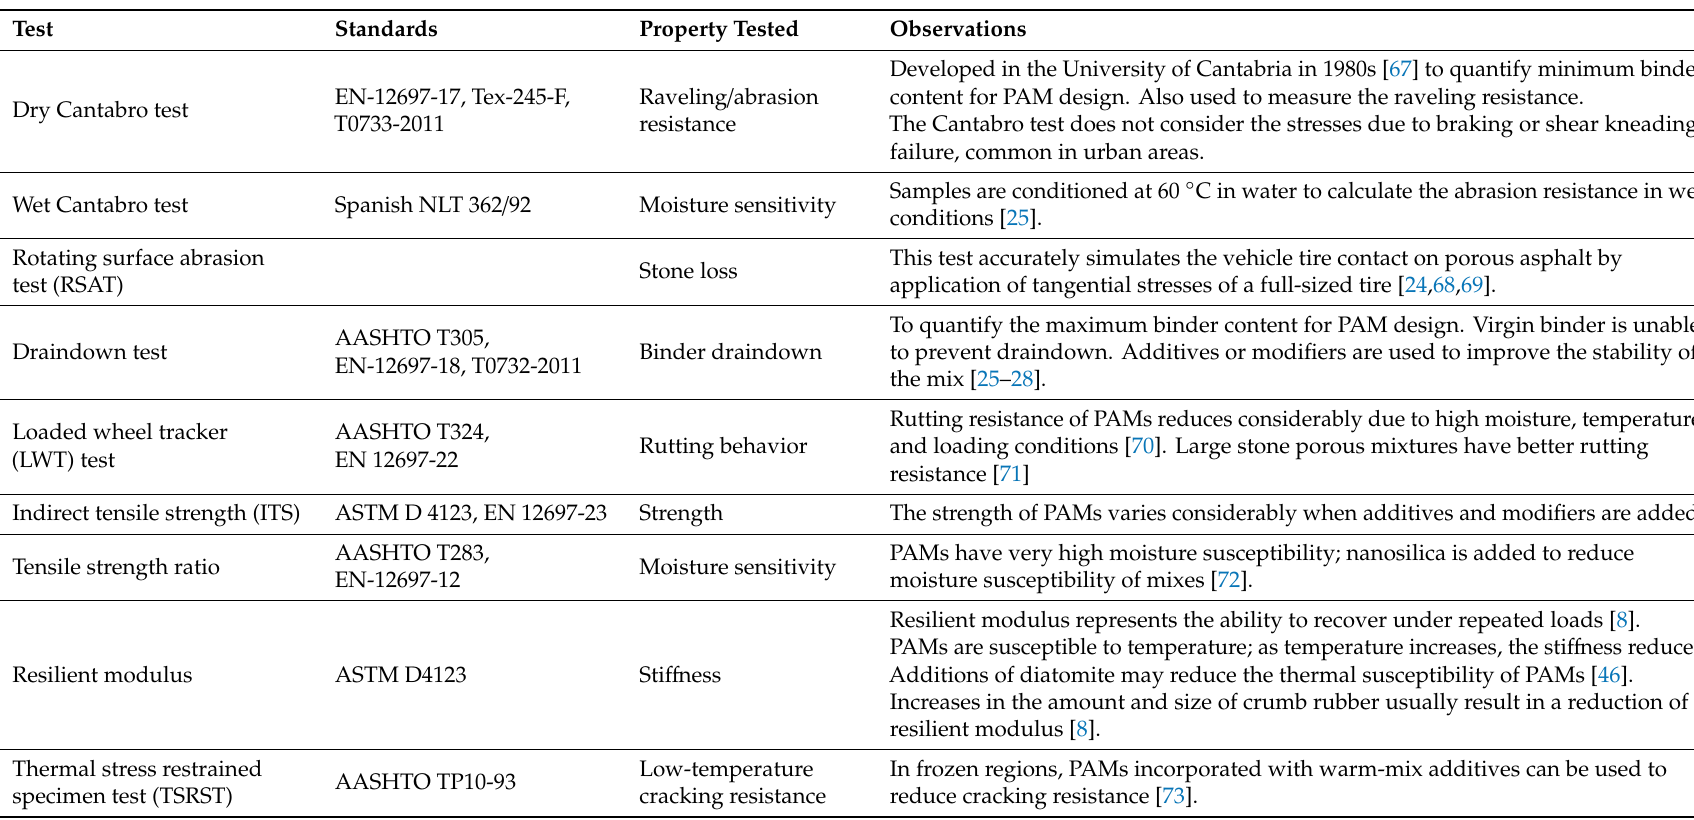
Table 1. Tests for mechanical resistance and functional performance of porous asphalt mixtures